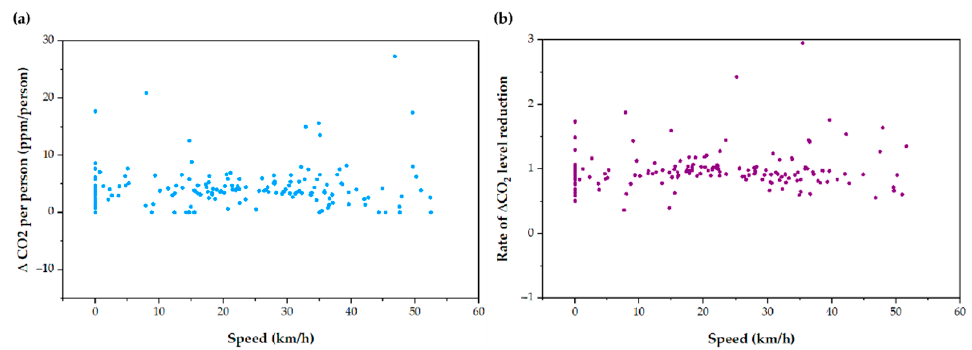
Figure 9. CO 2 measurements depending on Tram speed. ( a ) ∆ CO 2 per person ratio, and ( b ) average reduction rate of ∆ CO 2 depending on the Tram speed.